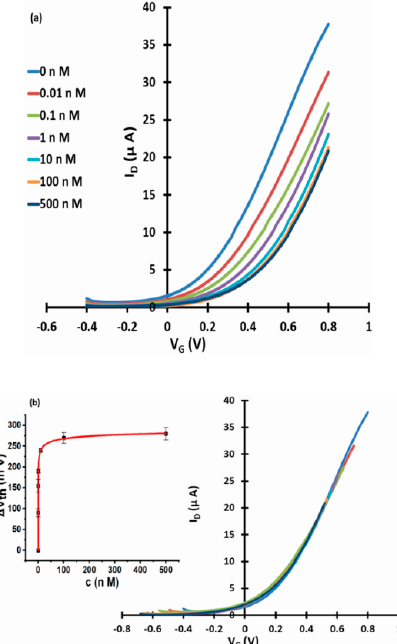
Figure 4. WGTFT fluoride (from KF) response with La resin membrane. ( a ) Transfer characteristics of La-loaded chelating resin-sensitised SnO 2 WGTFT gated under increasing F - concentrations from KF in the outer pool. ( b ) Master transfer characteristic. Inset to 4b: response characteristic with fit to Equation (3).